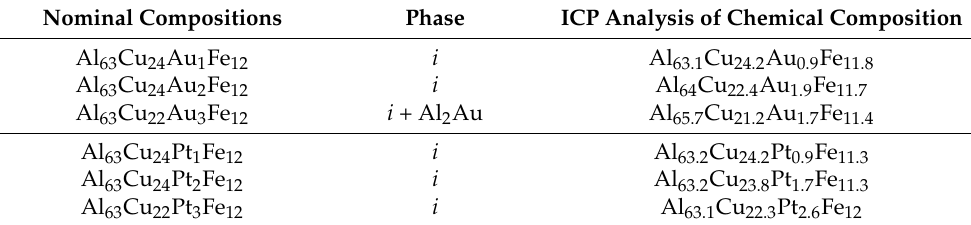
Figure 2. Quasilattice constant of Al 63 Cu 25 − x (Au,Pt) x Fe 12 ( x = 0, 1, 2, 3). Table 2. Nominal compositions and ICP results for Al 63 Cu 25 − x (Au,Pt) x Fe 12 ( x = 1, 2, 3). Nominal Compositions Phase ICP Analysis of Chemical